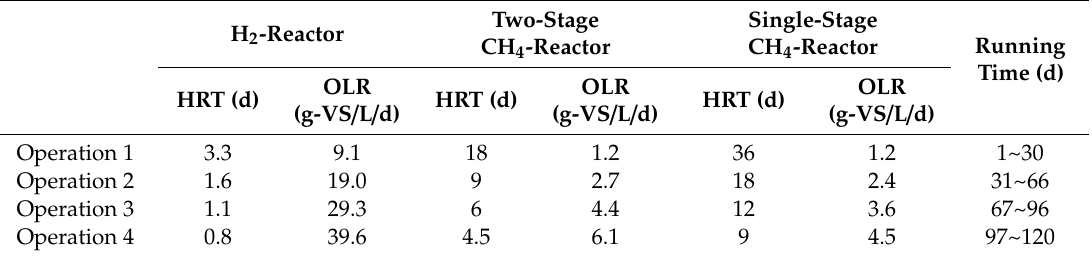
Table 2. The operating conditions in the experiment.